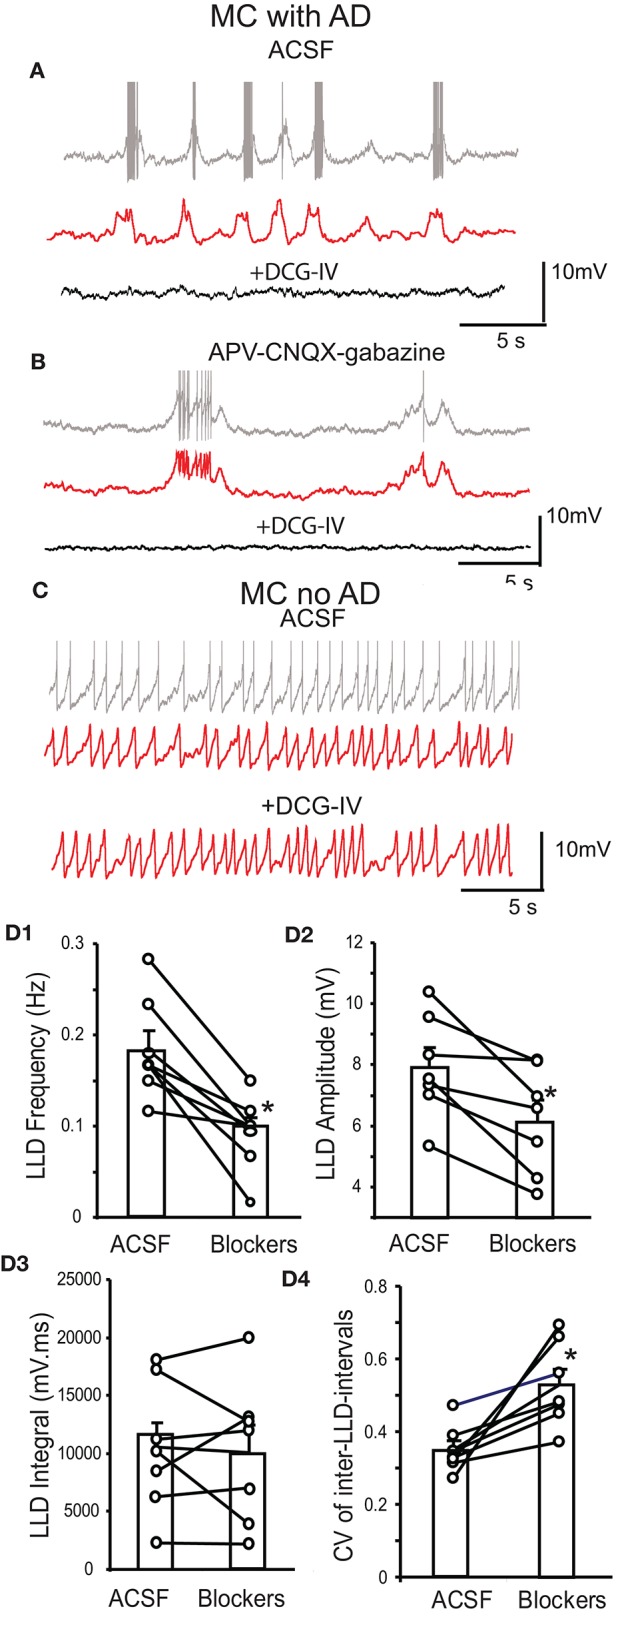
Spontaneous LLDs and membrane potential oscillations in mitral cells. (A) Upper trace - example current clamp record shows that a mitral cell (MC) with an intact apical dendrite (AD) in normal ACSF exhibits rhythmic bursting associated with LLDs. Middle trace - low pass filtered record of upper trace more clearly reveals underlying LLDs. Lower trace - DCG-IV eliminates spiking and LLDs. (B) In APV-CNQX-gabazine, this mitral cell with intact apical dendrite exhibits spike bursts or single spikes associated with LLD-like membrane potential oscillations (upper trace), as also seen in the middle filtered trace. Lower trace - DCG-IV terminates spiking and membrane potential oscillations. (C) An example mitral cell with truncated apical dendrites does not exhibit LLD-like membrane potential oscillations in raw (upper) or filtered traces (middle, lower). (D1–4) Mitral cell group data showing LLD properties in normal ACSF and APV-CNQX-gabazine; n = 7, *p < 0.05, paired t-tests.